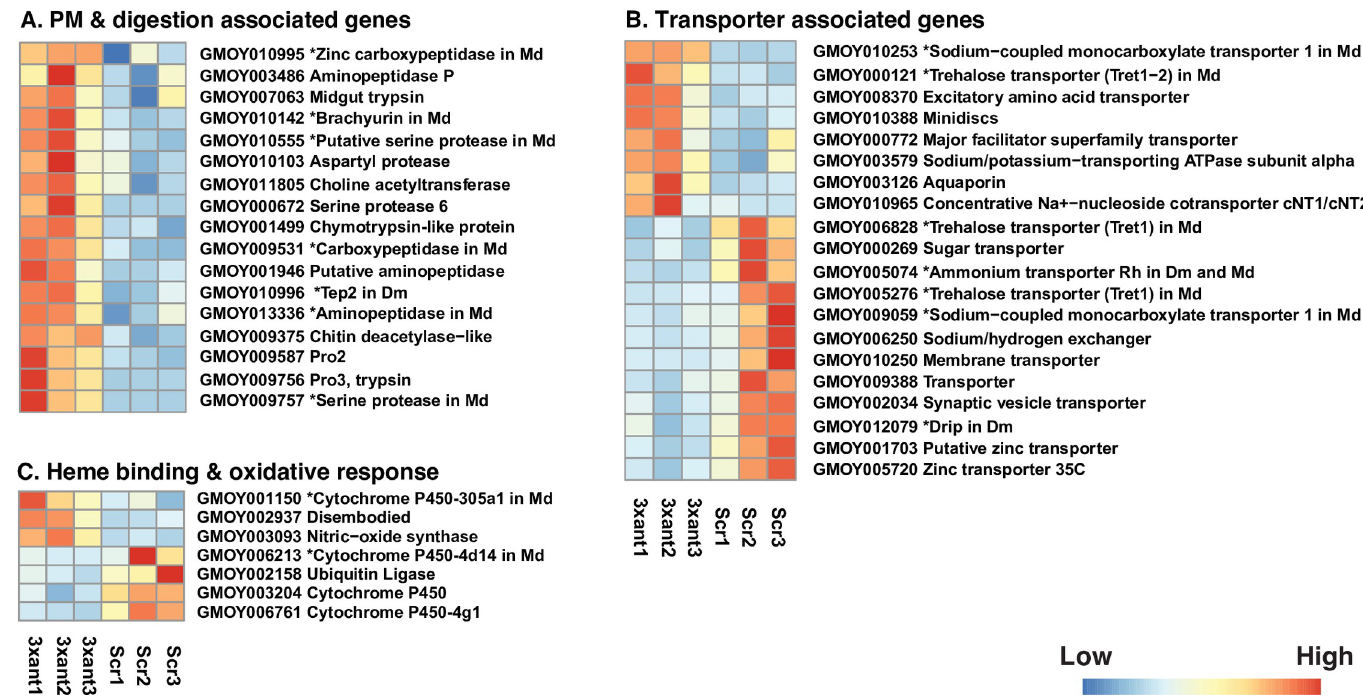
Fig 6. Heat map representation of DE genes in different functional groups (A-C) in the midgut of Gmm 3xant- miR275 and Gmm Scr-275 flies. (A) PM and digestion associated, (B) transporter associated, and (C) heme binding and oxidative response associated. Heat maps were generated by plotting the read counts in in treatment (3xant- miR275 ) and control (Scr-275) samples. Colors display normalized gene expression values from low (blue) to high (red). � indicates the unknown gene product’s orthologue in Drosophila melanogaster ( Dm ) and/or Musca domestica ( Md) .